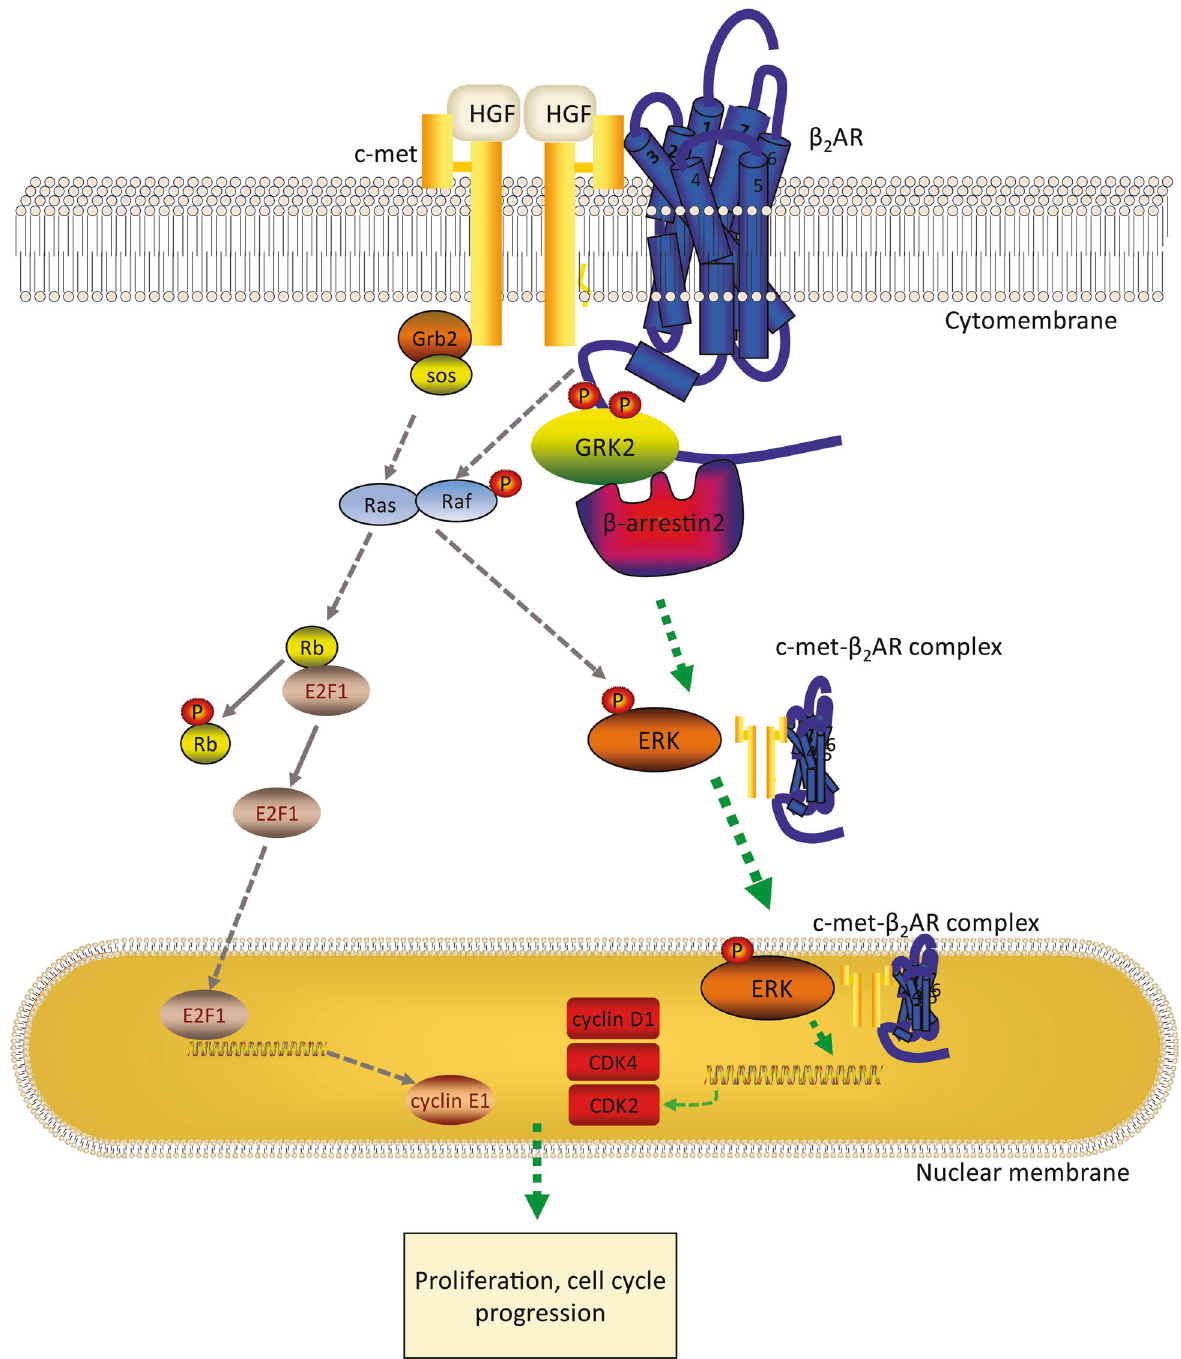
Fig. 8 β 2-adrenergic receptor promotes liver regeneration partially through crosstalk with c-met. Model of β 2 AR as a critical factor that regulates hepatocyte proliferation during liver